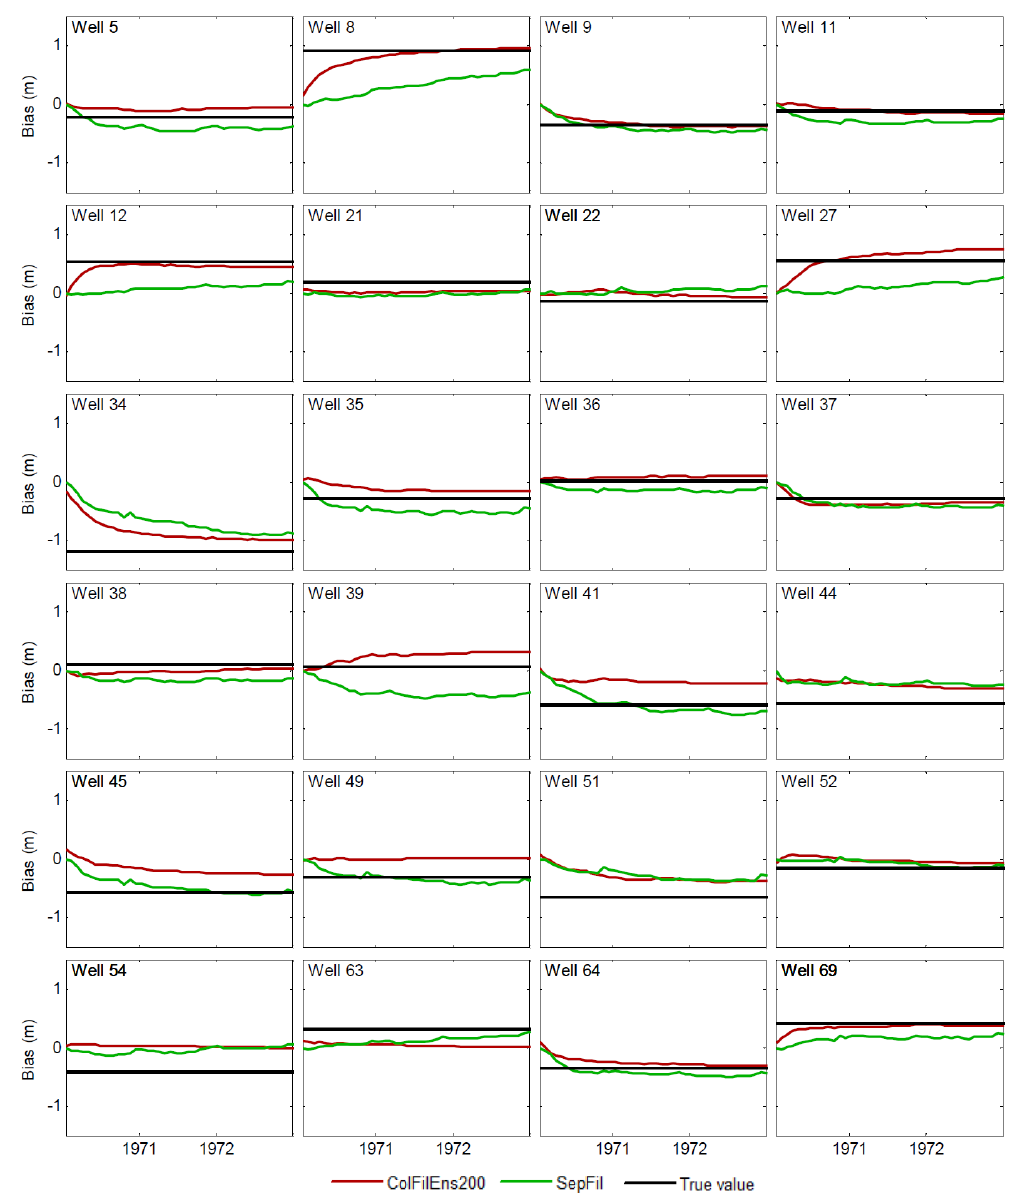
Figure 7. Estimated bias in the ColFilEns200 and SepFil scenarios as a function of time in the synthetic tests, compared to the true bias value used to generate the biased